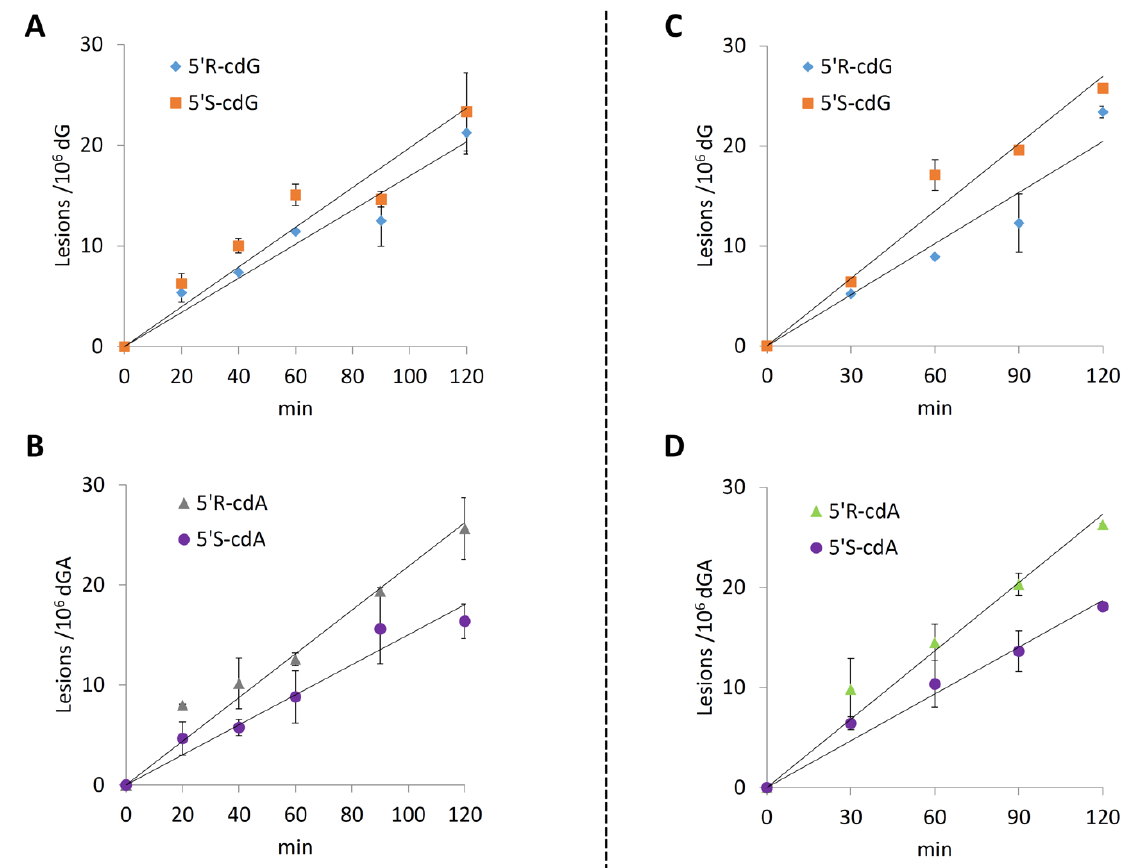
Figure 13. Kinetic study by Fenton reaction. (A and B): CuCl 2 /H 2 O 2 /Ascorbate-induced formation of 5 ′ R -cdG, 5 ′ S -cdG, 5 ′ R -cdA and 5 ′ S -cdA at 0, 20, 40, 60, 90 and 120 min. ds-(ODN5/ODN6) treated with CuCl 2 (15 µM), H 2 O 2 (120 µM), Ascorbate (1.2 mM); (C and D): Fe 2+ /H 2 O 2 /Ascorbate-induced formation of 5 ′ R -cdG, 5 ′ S -cdG, 5 ′ R -cdA and 5 ′ S -cdA at 0, 30, 60, 90 and 120 min. ds-(ODN5/ODN6) treated with Fe 2+ (15 µM), H 2 O 2 (120 µM), Ascorbate (1.2 mM). All points are the mean value (± standard deviation) of n = 2 independent experiments.